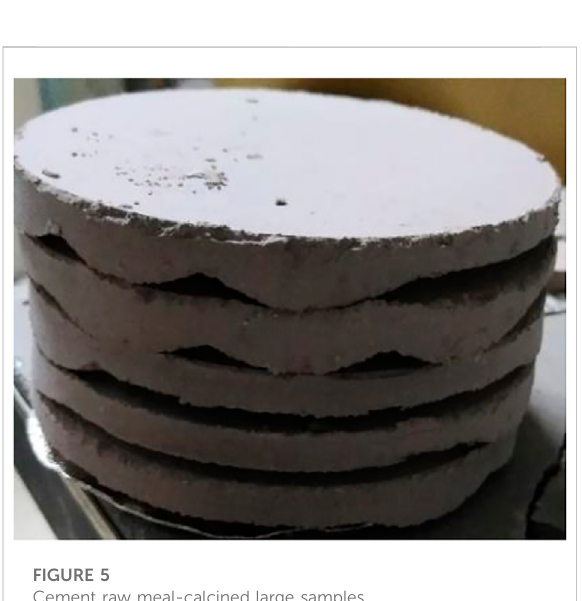
FIGURE 5 Cement raw meal-calcined large